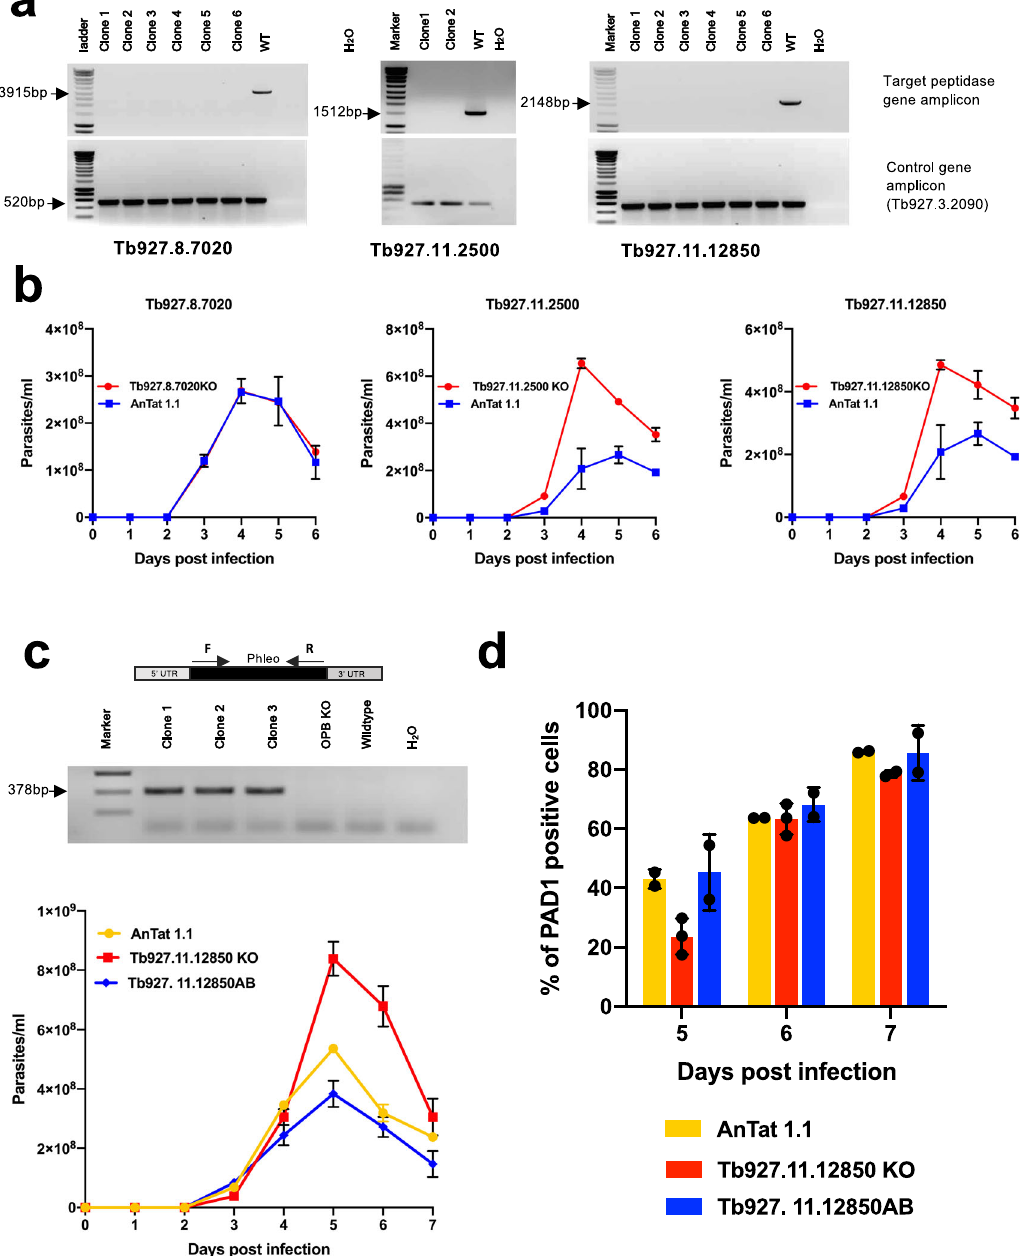
Fig. 5 Null mutants for two released peptidases show reduced quorum sensing. a PCR analysis of genomic DNA derived from null mutants of Tb927.8.7020, Tb927.11.2500 and Tb927.11.12850 analysed using gene-speci fi c primers. Several null mutant clones were analysed in each case, together with wild-type parental parasites. For each target gene no amplicon was detected with the null mutant clones, whereas a band of the expected size was detected using gDNA from wild-type parasites. Integrity of the gDNA in each case was validated using primers targeting a control gene (lower panels). b Parasitaemias (mean ± SEM) of infections initiated with null mutant line (red) or parental line (blue) for each target gene. Biologically independent replicate infections are shown ( n = 2), with Tb927.11.2500 and Tb927.11.12850 showing elevated parasitaemia. Note that the scales differ on the y axis between graphs. c Upper panel- PCR con fi rmation of the successful add back of a copy of Tb927.11.12850 to the null mutant. Lower panel- parasitaemias (mean ± SEM) of biologically independent infections initiated with parental T. brucei AnTat 1.1 parasites (yellow, n = 2), a Tb927.11.12850 null mutant (red, n = 3), or the Tb927.11.12850 null mutant containing an add back for the gene (blue, n = 2). The null mutant exhibited elevated parasitaemia re fl ecting reduced differentiation, whereas the add back of the Tb927.11.12850 gene restored the growth pro fi le to levels similar to the parental line. d PAD1 expression of parasites at day 5, 6 and 7 post infections. The null mutant exhibited reduced PAD1 expression at peak parasitaemia compared to the parental cells or add back line in biologically independent analyses (respectively n = 3, n = 2, n = 2). Beyond day 5, PAD1 levels were similar between lines, re fl ecting that the null mutant exhibited delayed but not abrogated stumpy formation, with stumpy parasites further enriched due to their enhanced tolerance of the developing immune response beyond day 5. Source data are provided as a source data fi le.